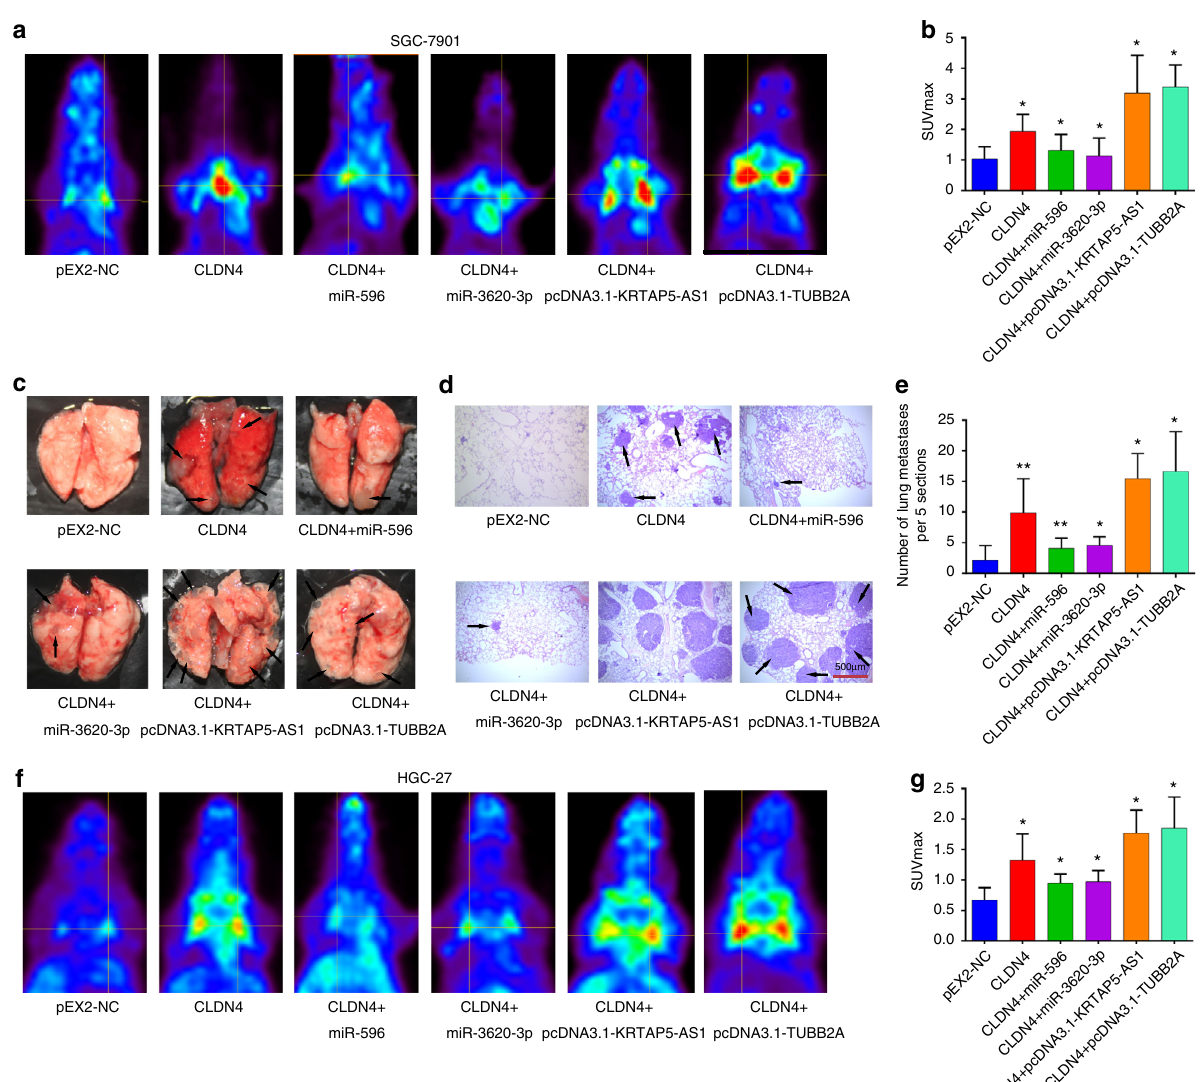
Fig. 9 The metastasis promoting effect of CLDN4 could be regulated in vivo. a , b Transverse section of 18F-FDG PET images of mice at the 56 day after tail vein injection with 1 × 10 6 SGC-7901 cell clones and the max SUVs were analyzed in each group. Data are mean ± s.d. of the tumor volumes, n = 8, * P < 0.05. c The gross lesion of lung tissues isolated from the mice. d The microscopic images of lung tissue sections stained by hematoxylin and eosin. Scale bars = 500 μ m. e The number of metastatic nodules in the lungs from 56 days after tail vein injection in a ( fi ve sections evaluated per lung). Data are mean ± s.d. of the tumor volumes, n = 8, * P < 0.05. f , g Transverse section of 18F-FDG PET images of mice at the 56 day after tail vein injection with 1 × 10 6 HGC-27 cell clones and the max SUVs were analyzed in each group. Data are shown as mean ± s.d. of the tumor volumes, n = 8. The data statistical signi fi cance is assessed by Student ’ s t -test. * P <